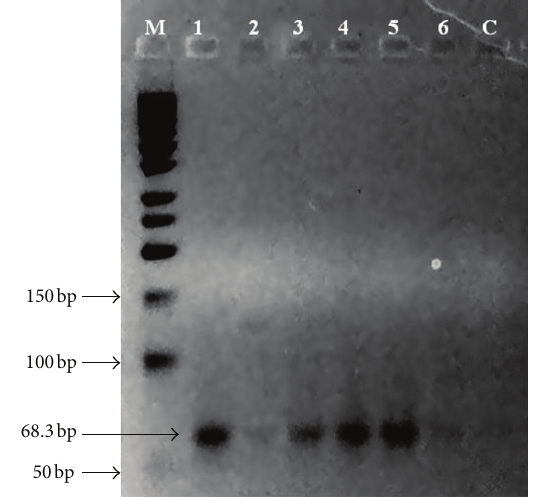
Figure 4: Amplification profile of SSR primer P4T10 (1:AM, 2:FM, ladder, and